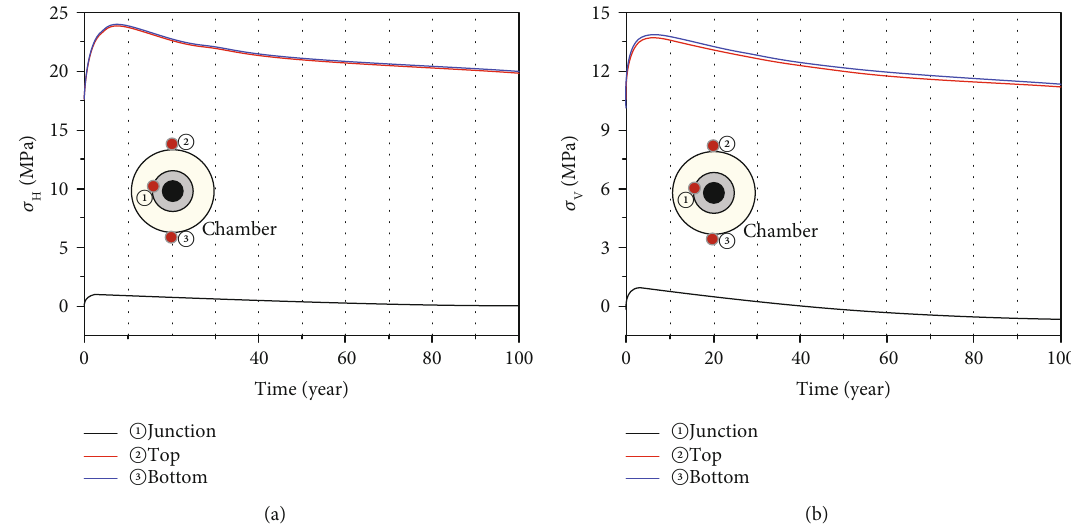
Figure 10: The change curve of principal stress at the monitoring point with time: (a) The relationship between σ relationship between σ and v